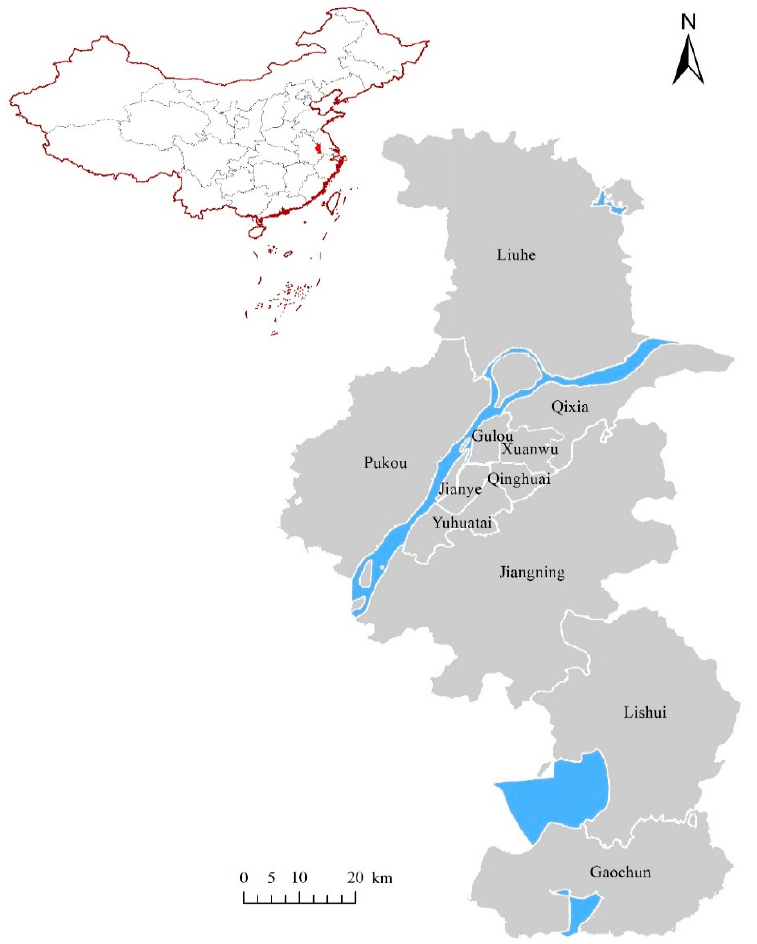
Figure 1. Administrative map of Nanjing.